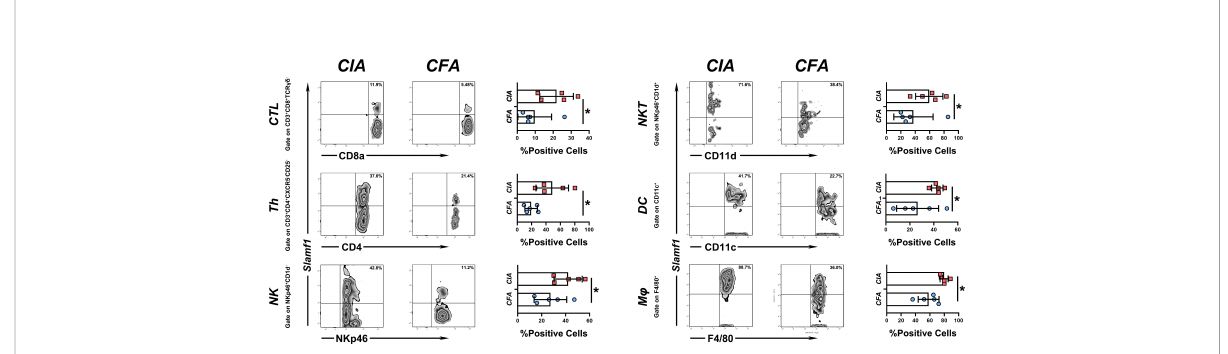
FIGURE 5 Expression level of slamf1 on different immune cell subsets PBMC from CIA and CFA mice were stained with respective surface markers and grouped into different immune cell subsets, the expression of SLAMF1 were detected by fl ow cytometry and analysis by mean fl uorescence intensity (MFI). Data shown are the mean ± SEM with 6 mice per group and are from one experiment, representative of two performed. *p <0.05, **p < 0.01 and ***p < 0.001 (Wilcoxon rank-sum